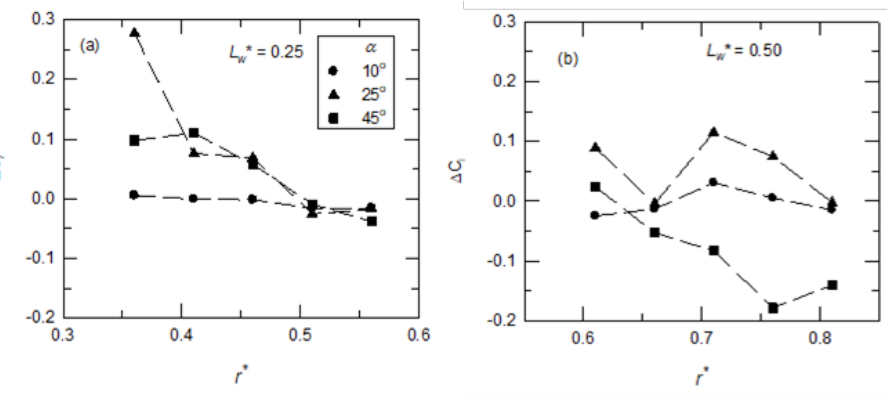
Figure 12. The differences in the sectional lift coefficients ( C l ) at different x-z planes at different angles of attack. The wing model was equipped with an alula-VG at different y-positions: ( a ) L w * = 0.25 ( r* = 0.37), ( b ) L w * = 0.50 ( r* = 0.62). For the model with an alula-VG placed at the outboard of the wing ( L w * = 0.50 or r* = 0.62), the sectional lift coefficient still showed almost no difference at a small angle of attack ( α = 10 ◦ ). At α = 25 ◦ , there was a decrease in the value of ∆ C l at r* = 0.66, which was because there was lift-off and bursting of the LEV. For the post-stall condition ( α = 45 ◦ ), the value of ∆ C l was negative at r* = 0.66–0.81, which was also due to the vortex bursting and flow separation on the upper surface of the wing. The variations in the sectional